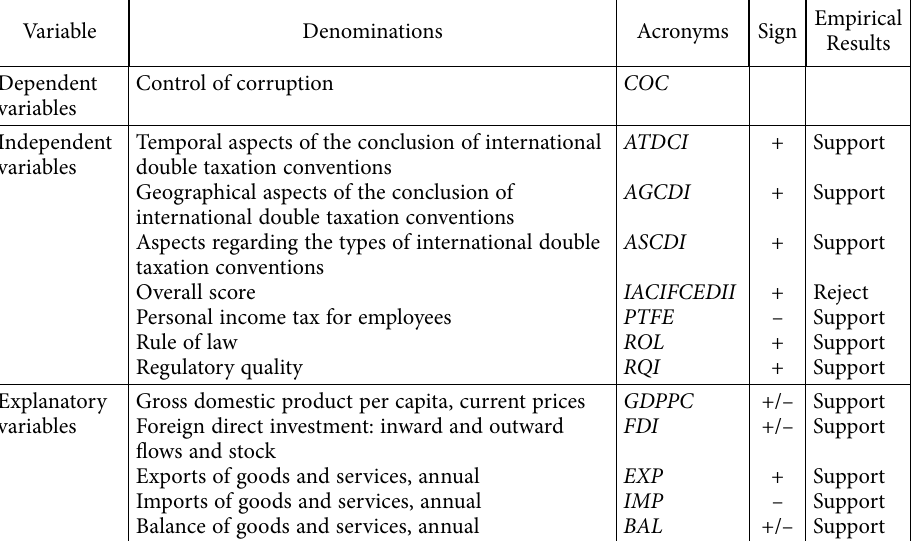
Table 15. Derived signs of the independent and explanatory variables in equation and validation by the empirical results – Eq. (2) (source: own processing)